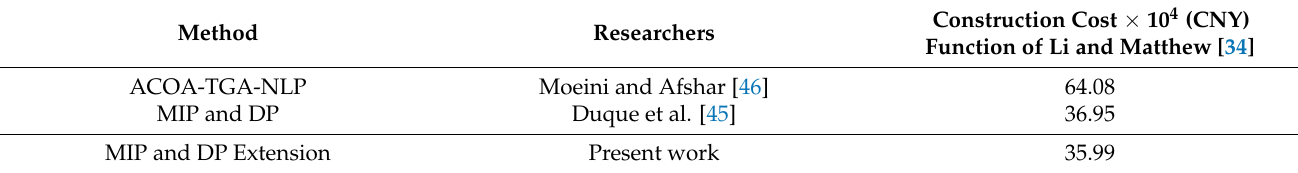
Table 6. Construction cost with different methods for the benchmark proposed by Moeini and Afshar [46]. Method